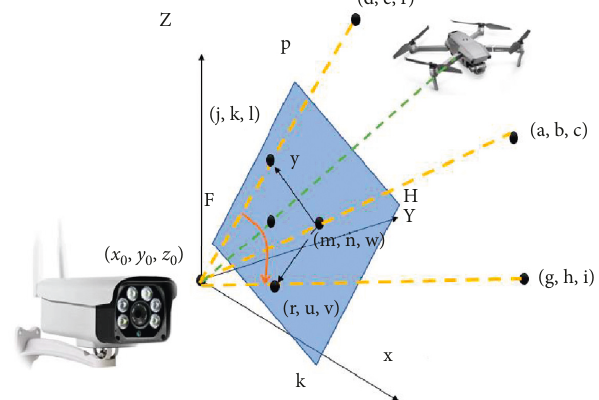
Figure 3: The coordinate conversion of